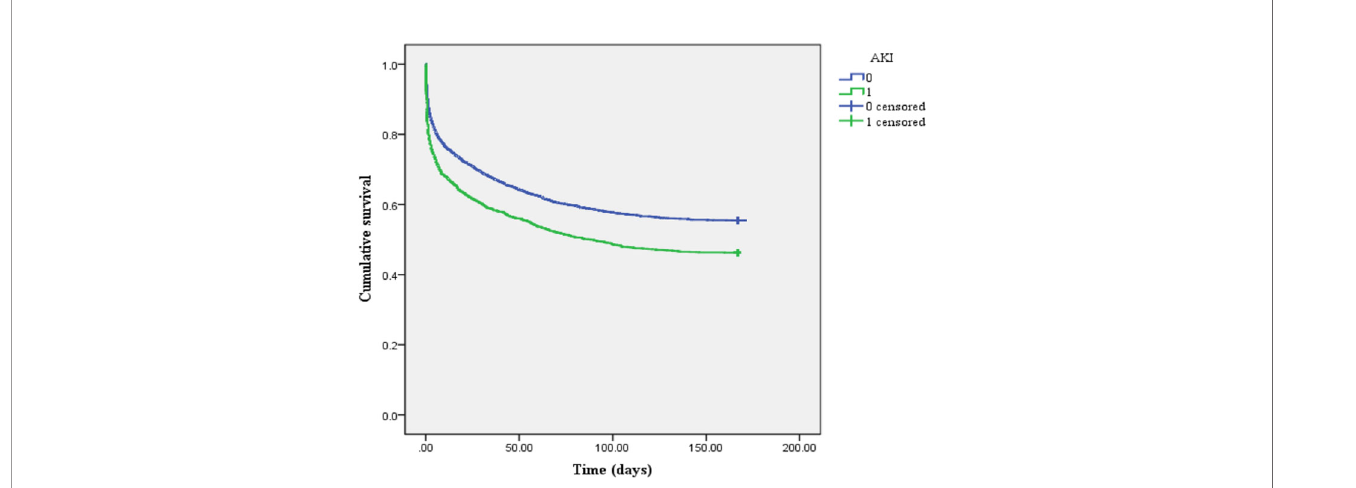
FIGURE 2 | Kaplan – Meier survival curve of patients between acute kidney injury (AKI) and non-AKI groups (1 represents AKI group, and 0 represents non-AKI